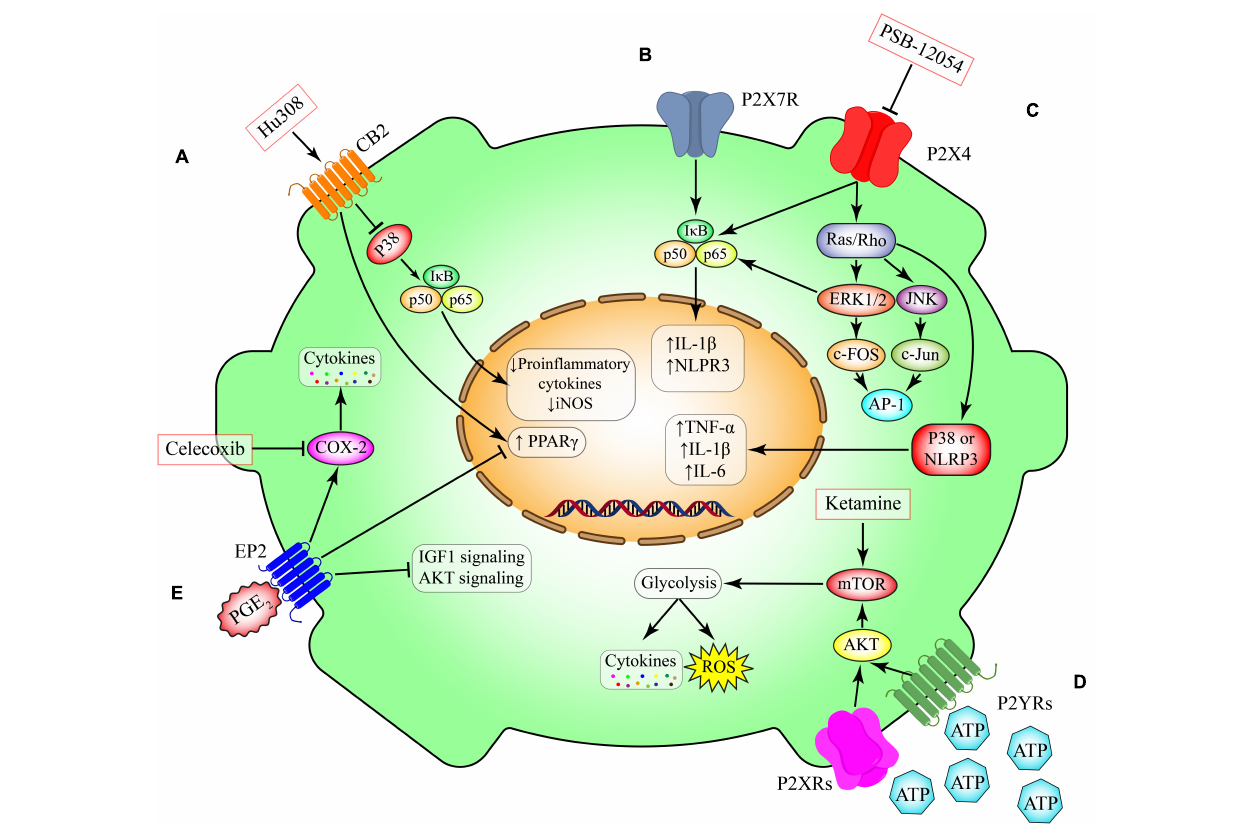
FIGURE 3 | Metabolic pathways in microglia. (A) Activation of CB2 receptors that are expressed in non-neural cells including microglia promotes anti-inflammatory cascades through inhibition of NF κ B or induction of anti-inflammatory transcriptional factor such as peroxisome proliferator-activated receptor gamma (PPAR- γ ). This pathway can be induced by Hu308. (B) P2X7 receptor activation, induces the canonical pro-inflammatory transcriptional factors such as NF κ B and subsequent production of inflammatory mediators such as IL-1 beta and NLPR3. (C) Activation of ligand gated ion channel P2X4 triggers the switching on two canonical pathways including NF κ B and Ras/ERK/JNK. These proteins induce the production of several cytokines such as TNF- α , IL-beta and IL-6. This pathway can be inhibited by PSB-12054. (D) Induction of the G-protein coupled receptors P2YRs have essential roles in modulating the expression of metabolic pathways such as mTOR and their downstream glucose metabolism. The induction of glycolysis through mTOR has been implicated in production of several cytokines and chemokines. Ketamine triggers the mTOR pathways leading to induction of glycolysis. (E) Prostaglandin E2 (PGE 2) is a lipid mediator derived from the fatty acid arachidonic acid. Its interaction with the microglial G-protein coupled receptor EP2 induces the activity of cyclooxygenase-2 (COX-2) and inhibits several intracellular pathways including PPAR- γ , AKT and IGF1. Celecoxib is s selective COX-2 inhibitor. CB2, cannabinoid type 2 (CB2) receptor; P2X4, P2X purinoceptor 4; P2X7, P2X purinoceptor 7; P2YR, purinergic receptor P2Y; EP2, prostaglandin E2 receptor 2; PGE2, prostaglandin E2; IGF1, insulin-like growth factor 1; AKT, RAC(Rho family)-alpha serine/threonine-protein kinase; COX-2, cyclooxygenase-2; TNF- α , tumor necrosis factor- α ; iNOS, inducible nitric oxide synthase; IL-1 β , interleukin 1 beta; IL-6, interleukin 6; PPAR- γ , peroxisome proliferator- activated receptor-gamma; mTOR, mammalian target of rapamycin; AP-1, activator protein 1; JNK, c-Jun N-terminal kinases; NLRP3, NLR family pyrin domain containing 3; ERK, extracellular-signal-regulated-kinase; I κ B, nuclear factor of kappa light polypeptide